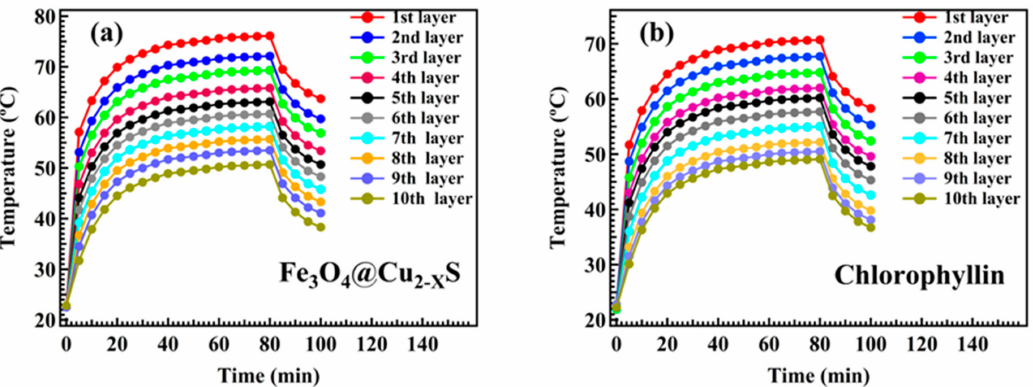
Figure 6. ( a ) Heating curves Fe 3 O 4 @Cu 2 − x S, ( b ) heating curves of chlorophyllin in 3D solar harvesting photothermal energy generator (Figure 5) [62]. Reprinted with permission from Lyu, Mengyao, Jou Lin, John Krupczak, and Donglu Shi. “Solar harvesting through multilayer spectral selective iron oxide and porphyrin transparent thin films for photothermal energy generation.” Advanced